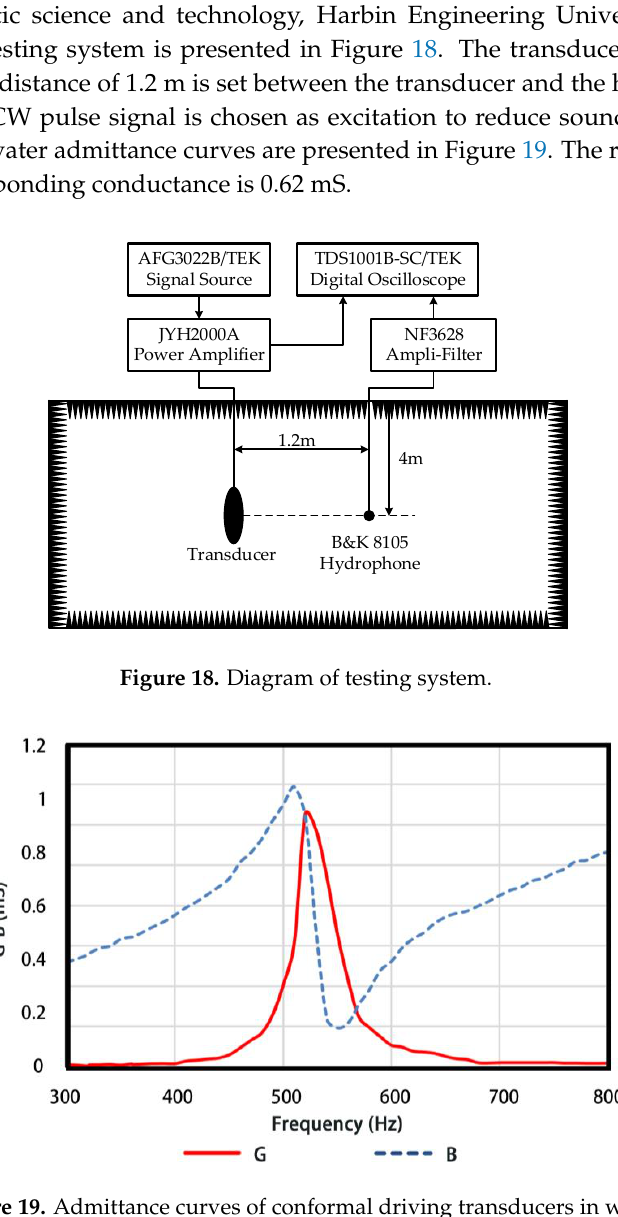
Figure 17. Photographs of the Conformal Driving Class IV FT at different stages of assembly.